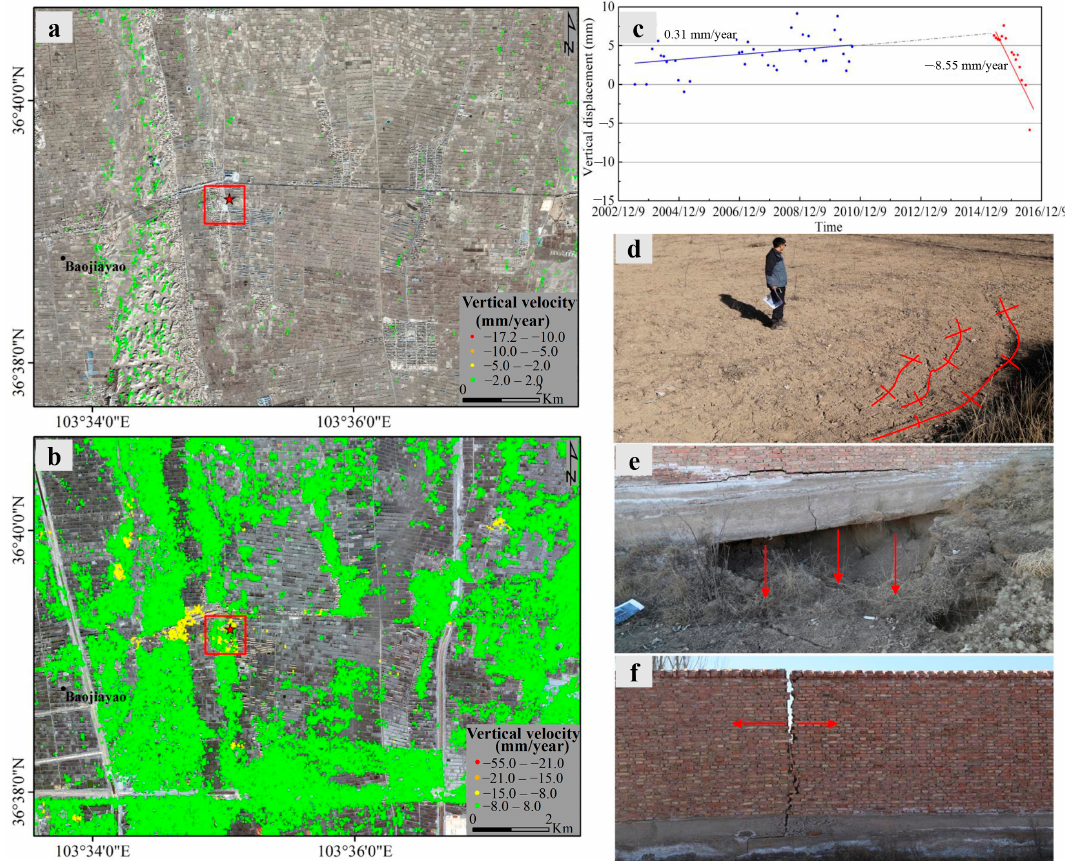
Figure 7. Typical subsidence observed in the main irrigation area located in the Western sector which has formed a geohazard chain: ( a ) Average 2003–2010 velocity map; the PSs were superimposed on the Google Earth image obtained on 3 March 2013. ( b ) Average 2015–2016 velocity map; the Coherent Targets were superimposed on the GF-1 satellite image acquired on 17 October 2016. Red stars in ( a , b ) indicate the location of the PSs and CTs selected, respectively. ( c ) Vertical displacement time-series and corresponding linear rates of subsidence. Envisat (blue) and Sentinel-1A (red) time series are shown. The gap between 2011 and 2014 was filled by a prediction trendline (grey dashed line in ( c )). Images of: ( d ) irrigation-induced ground fissures; ( e ) foundation settlement due to cultivated land subsidence; and ( f ) wall cracks resulted from foundation subsidence.